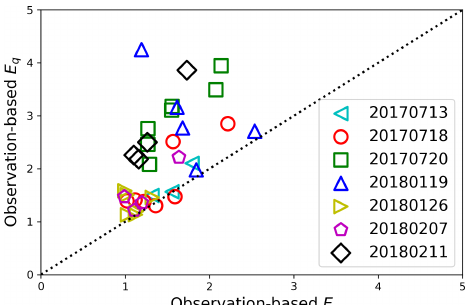
Figure 9. A comparison of observation-based E and observation- based E q for all the selected hlegs from all four selected